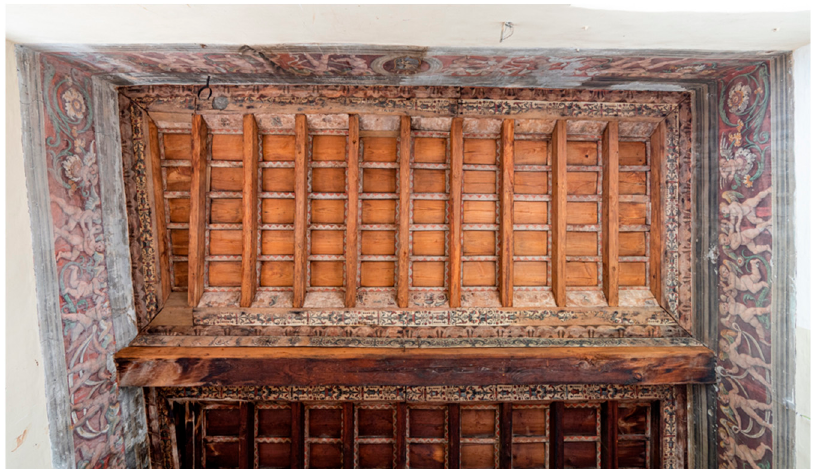
Figure 2. Ceiling of the Sala de Rossi, adjacent to that of Sala